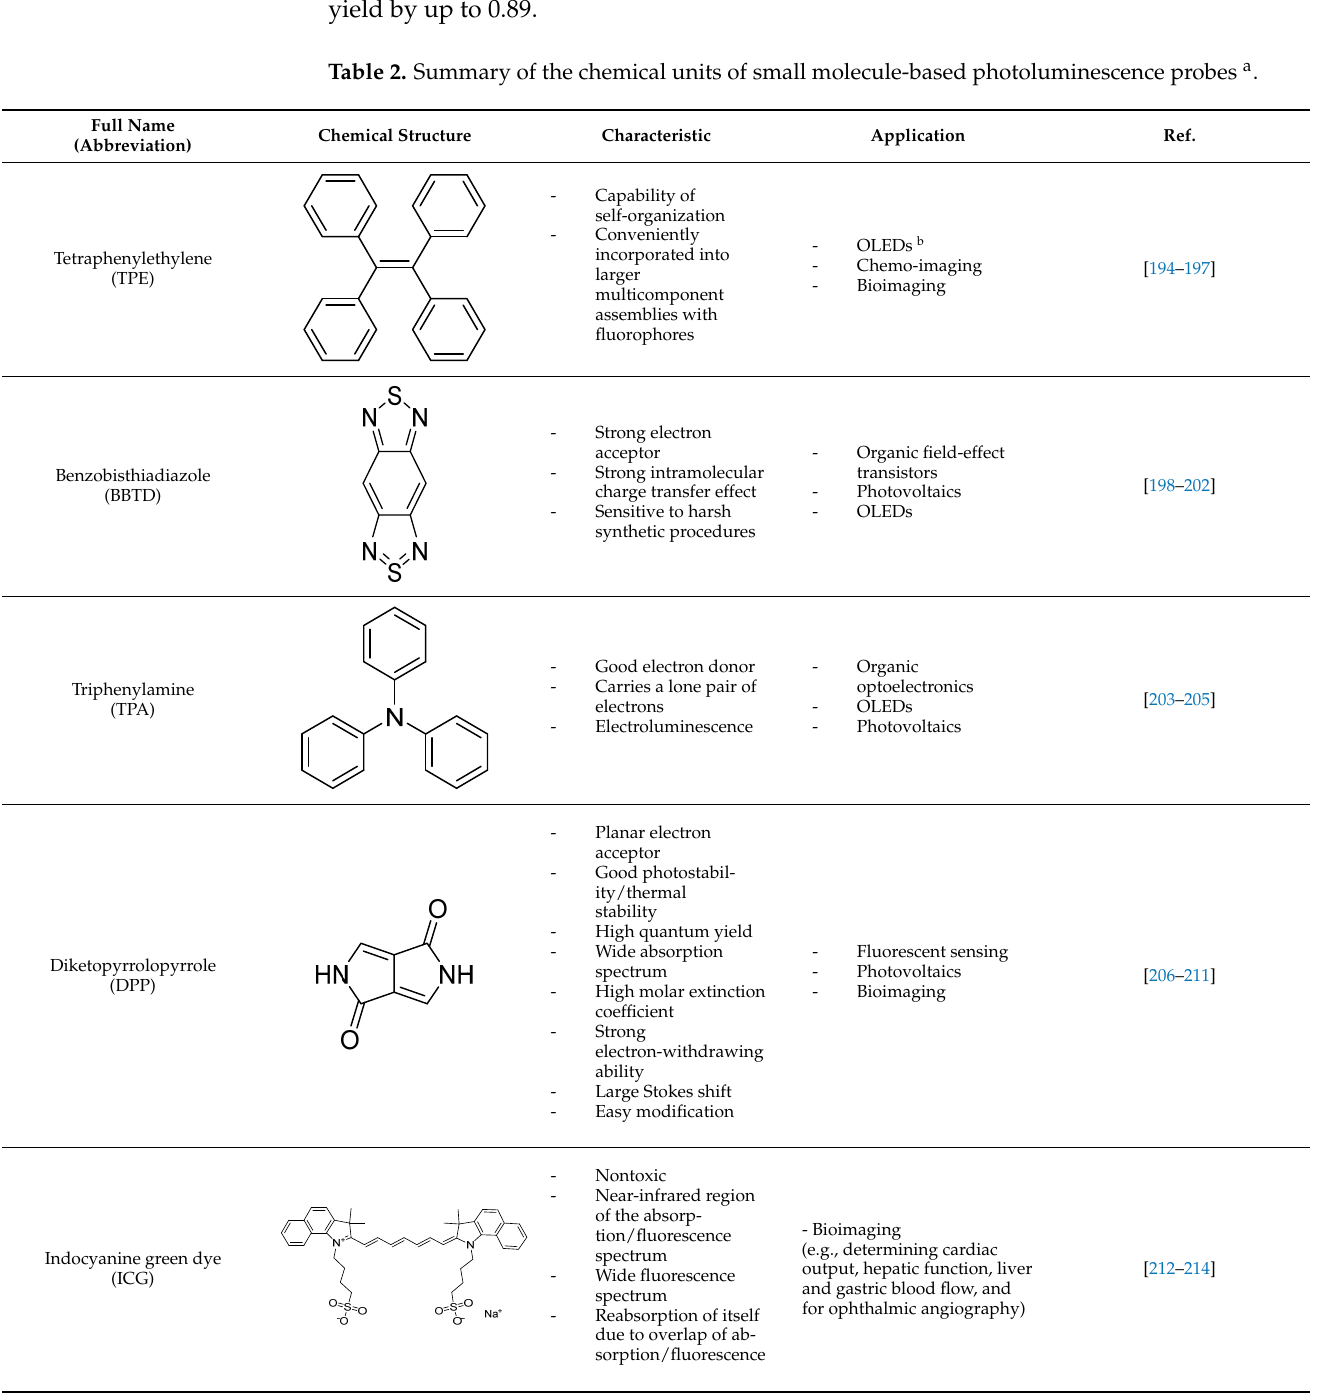
Table 2. Summary of the chemical units of small molecule-based photoluminescence probes a .